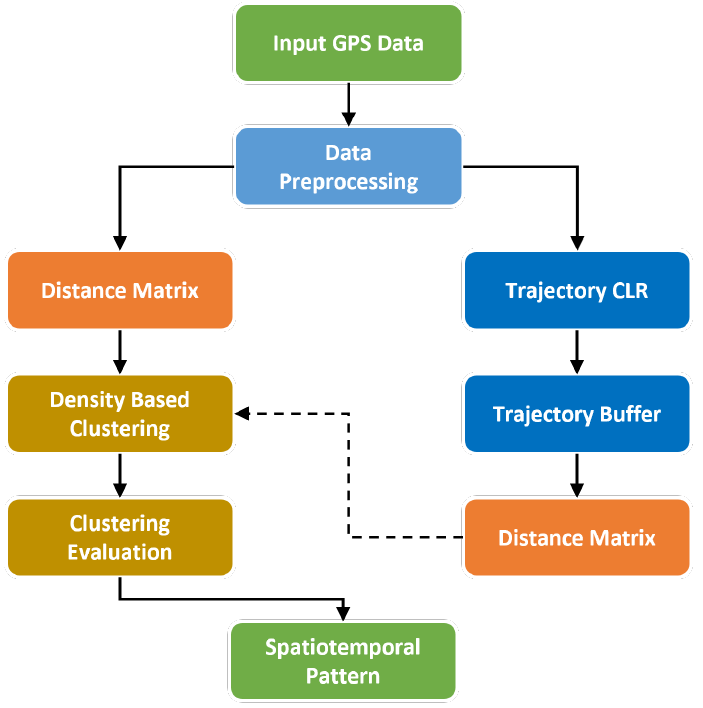
Figure 1. Overall framework of our proposed trajectory clustering